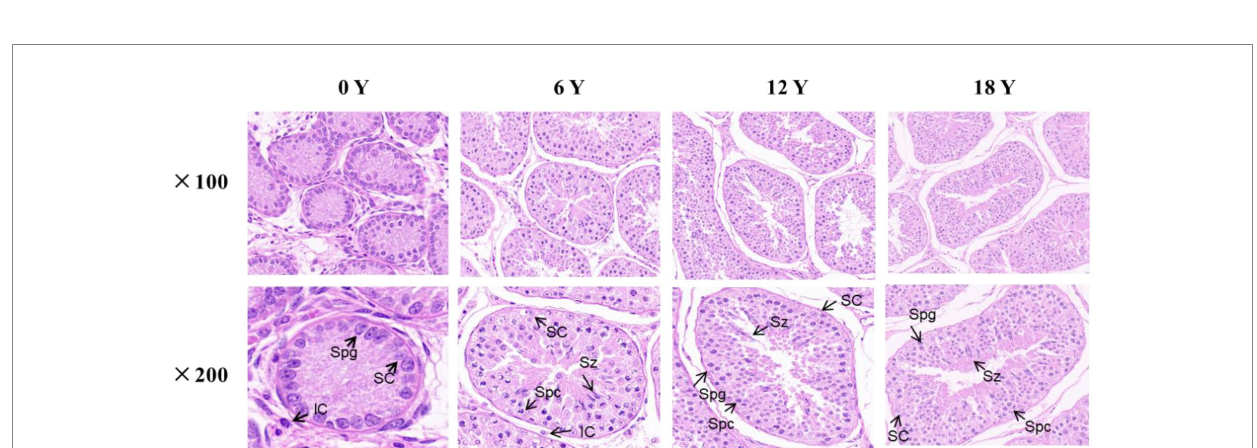
FIGURE 1 HE staining of testicular tissue from rams at different months of age. SC: supporting cells. Spg: spermatogonia. Spc: spermatocytes. LC: Leydig cells. Sz: